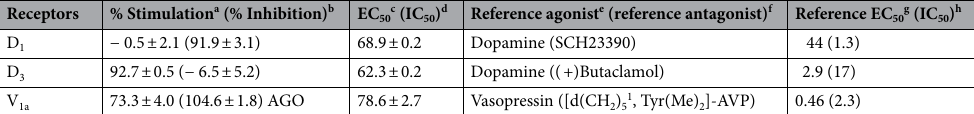
Table 4. Functional effect (% stimulation and % inhibition) and efficacy (EC 50 and IC 50 ) of isoliquiritigenin on human dopamine (D 1 and D 3 ) and vasopressin(V 1A ) receptors. a,b The % stimulation and the % inhibition denote the percentage of control agonist response and the percentage inhibition of the control agonist response by isoliquiritigenin at 100 µM. c The concentration producing a half maximal response (µM). d The concentration producing half maximal inhibition of the control agonist response (µM). e ,f Reference agonists and reference antagonists used in the assay. g The EC 50 value of the reference agonist (nM). h The IC 50 value reference antagonist (nM). AGO: The test compound induced at least 25% agonist or agonist-like effects at this concentration.